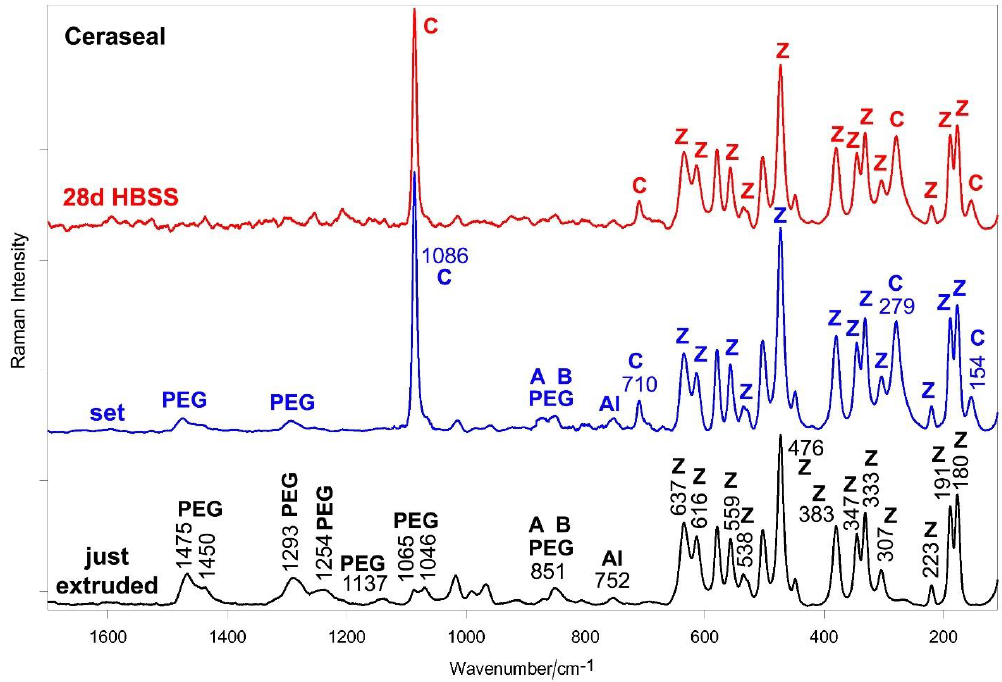
Figure 3. Average micro-Raman spectra recorded on just extruded Ceraseal (black) as well as on the surface of set disks before (blue) and after aging in HBSS for 28 days (red). The bands assignable to polyethylene glycol (PEG), tricalcium silicate (alite) (A), dicalcium silicate (belite) (B), tricalcium aluminate (Al), monoclinic zirconia (Z) and calcite (C) are indicated. PEG component was not indicated in the Material Safety Data Sheet.